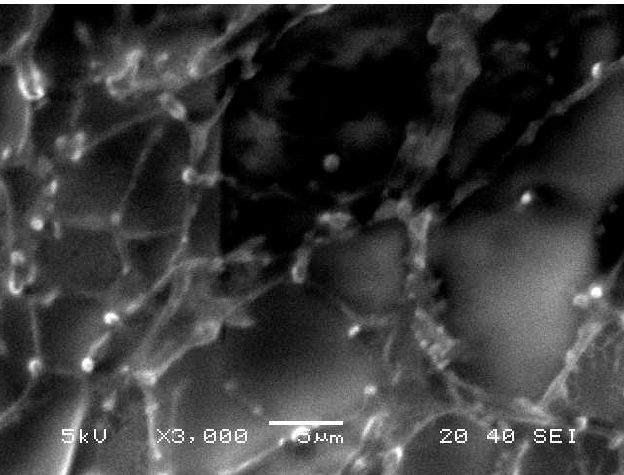
Figure 3. Scanning electron microscope (SEM) of Cur-loaded nanoemulgel.